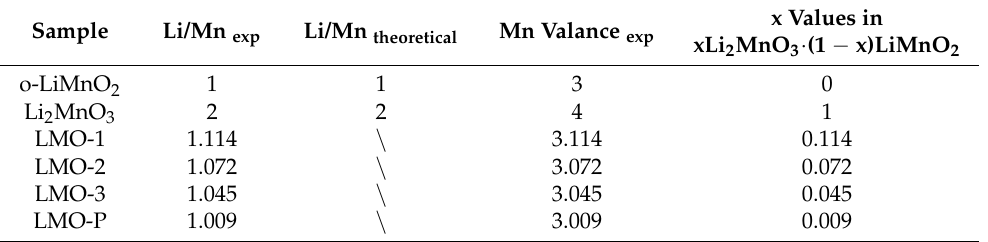
Table 1. The experimental results of the Li/Mn atom ratio, e Mn average valance, and corre- sponding calculated x-values. Table 2. Different manganese valences and their respective content obtained using the